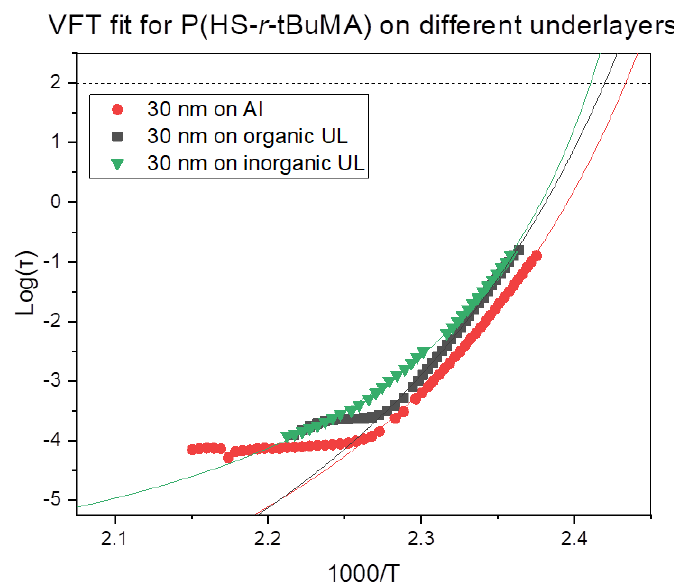
Figure 6. Comparison of VFT fits for P(HS- r -tBuMA) on the different underlayers.